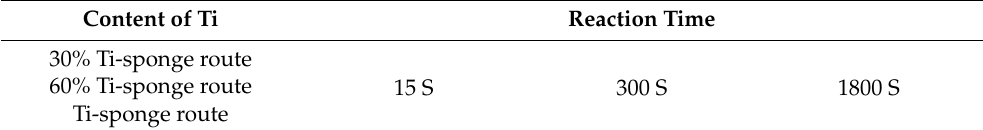
Table 2. Experimental parameters for the partial Ti-sponge route and the Ti-sponge route. Content of